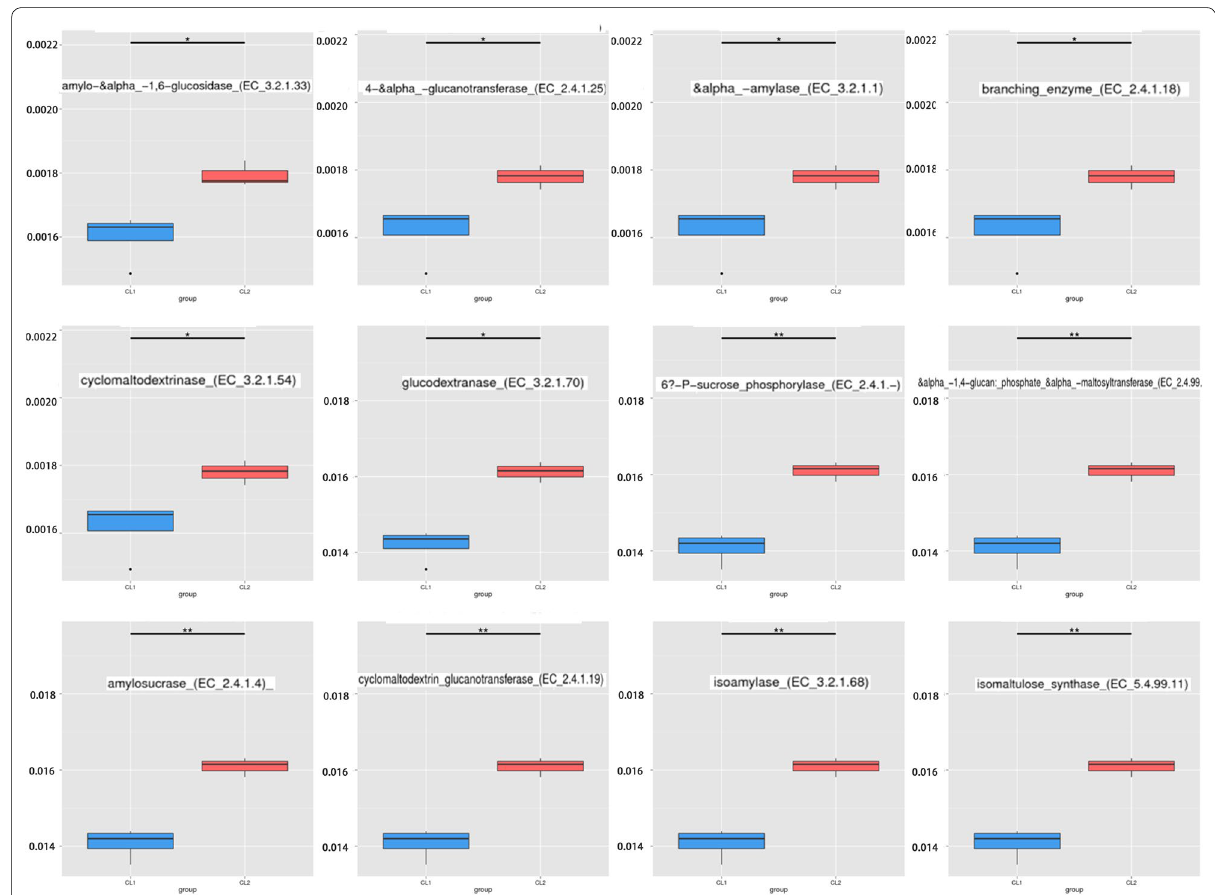
Fig. 7 Significantly different enzymes based on the CAZy